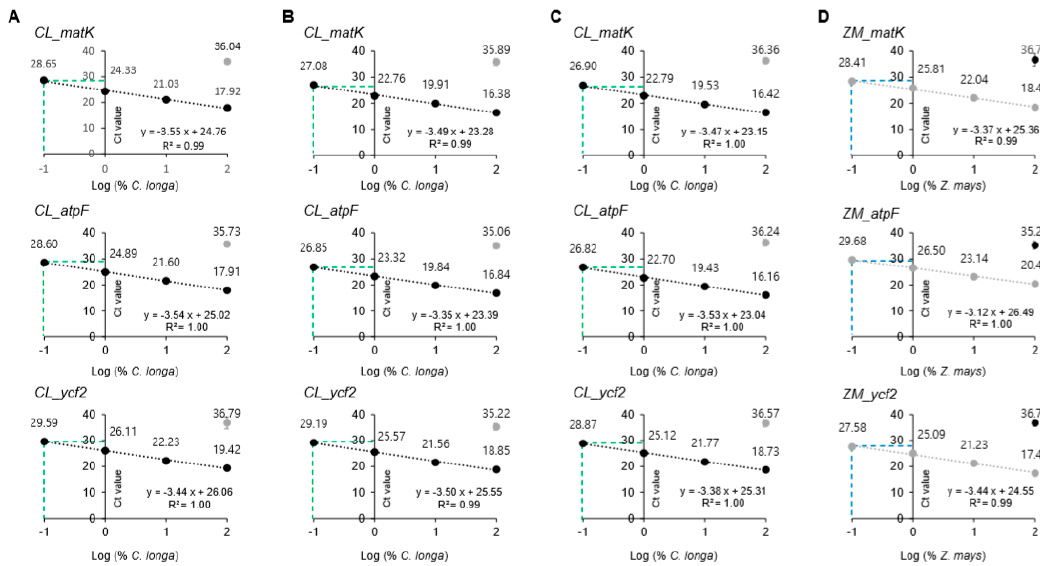
Figure 3. Standard curve of cycle threshold (Ct) values obtained on the basis of e ffi ciency and correlation of coe ffi cient ( R 2 ) by reference binary mixtures. The x -axis represents log percentage of the target species (%) and the y -axis represents means of Ct value ± SD. plotted against the logarithm of the target species concentration (100, 10, 1, and 0.1%). ( A – C ); each C. longa rhizome powders were mixed with three di ff erent plant powders ( Z. mays , O. sativa , and T. aestivum ) by ten-fold dilutions (0.1, 1, 10 and 100%, final mass of 2g) and the each mixture gDNA(10 ng / uL) was amplified using the C. longa targeting primer sets (CL_matK, CL_atpF, and CL_ycf2). The green dotted line means the 0.1% binary